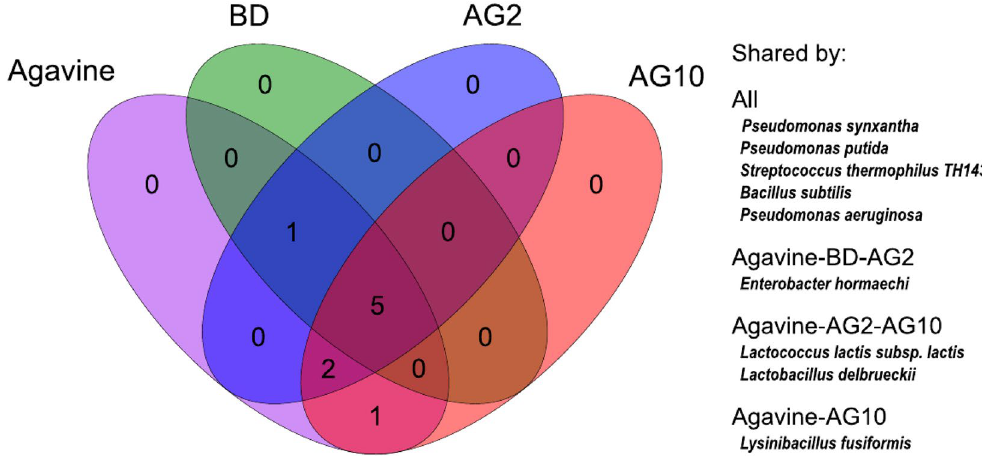
Figure 7. Venn diagram of beneficial microbes found between the agavin and experimental